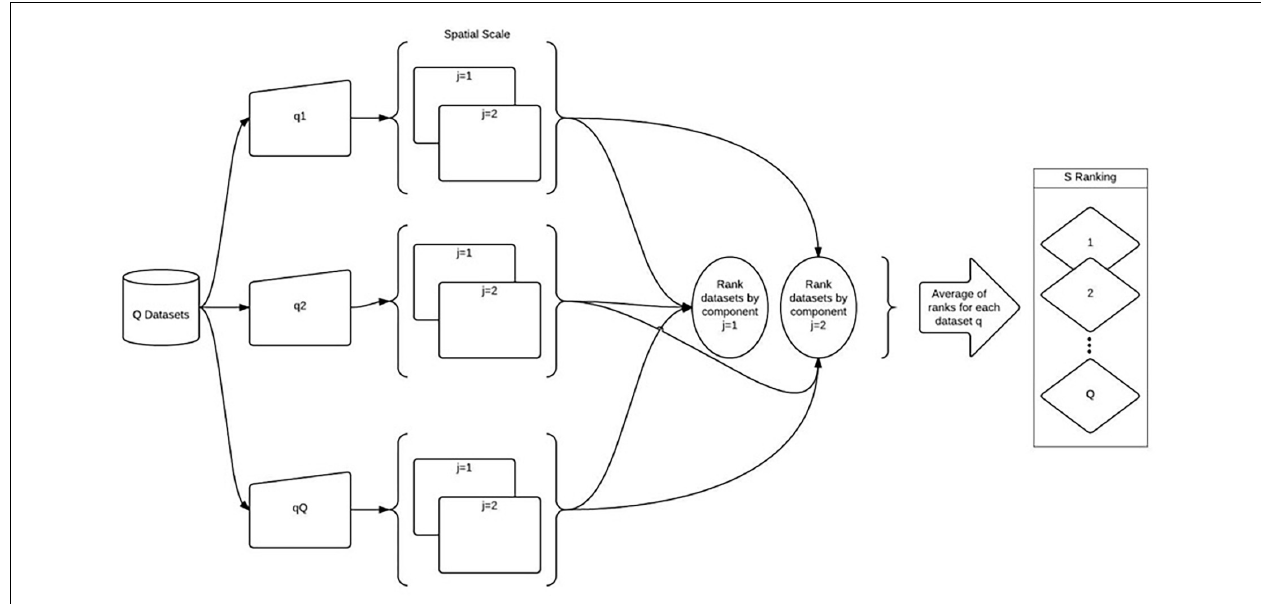
FIGURE 1 | Spatial Scale (S) component, adapted from Shimizu (2014).